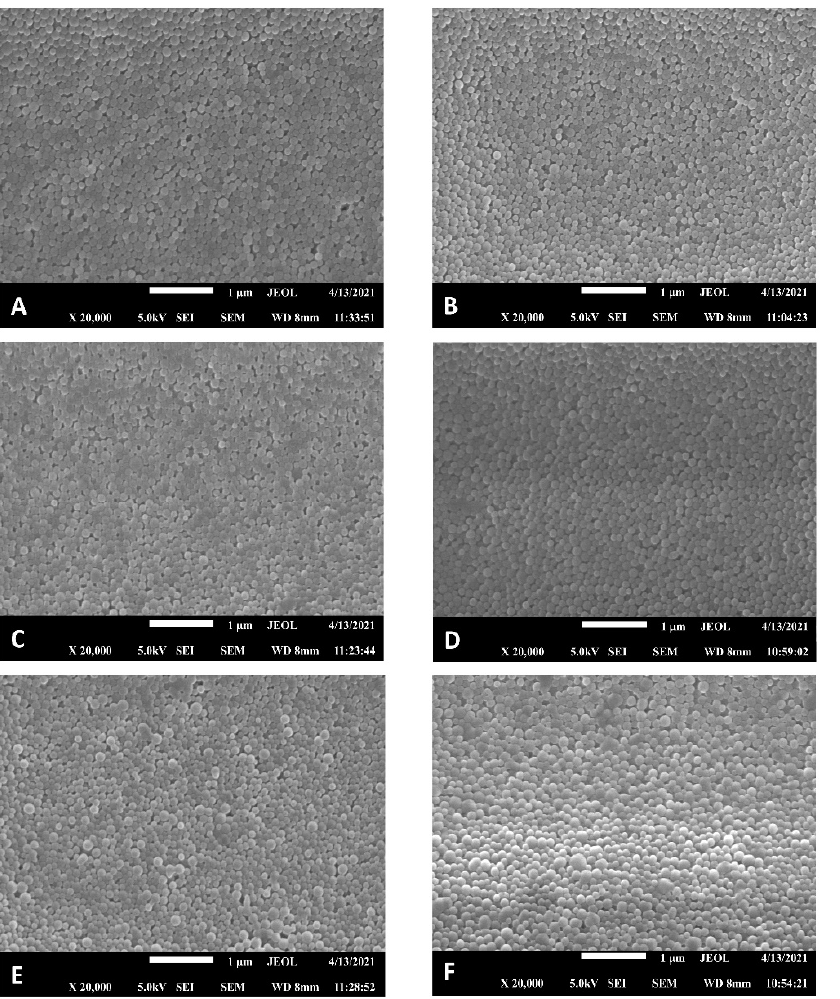
Figure 2. SEM images (x20,000) of all NPs formulations. ( A ) NP-0. ( B ) NPphe-0. ( C ) NP-MH. ( D ) NPphe-MH. ( E ) NP-Rh. ( F ) NPphe-Rh. MH: morin hydrate; phe: phenylalanine; Rh: rhodamine B. Table 2. Mean (±SD) particle size, zeta potential, drug loading (DL), and encapsulation efficiency (EE%) of the NPs formulations. Mean values of the polydispersity index (PDI). Particle Size ± Formulation